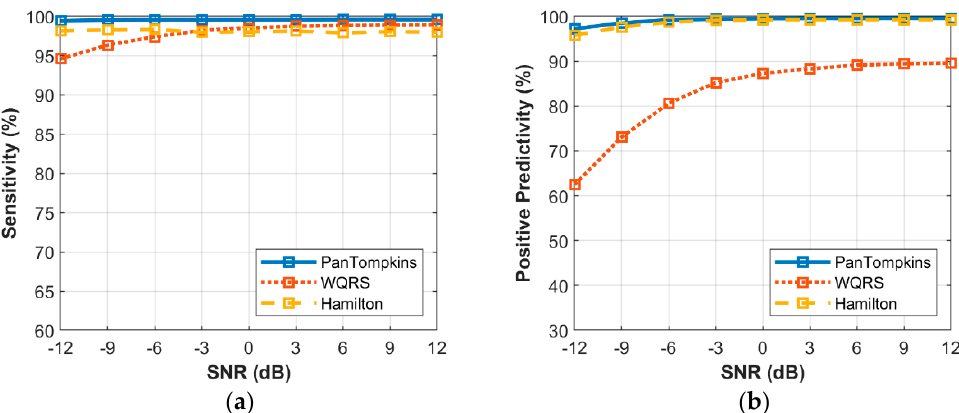
Figure 12. Relationship between the performance of beat detection and BW for all the 48 records: ( a ) sensitivity with SNR; ( b ) positive predictivity with SNR.